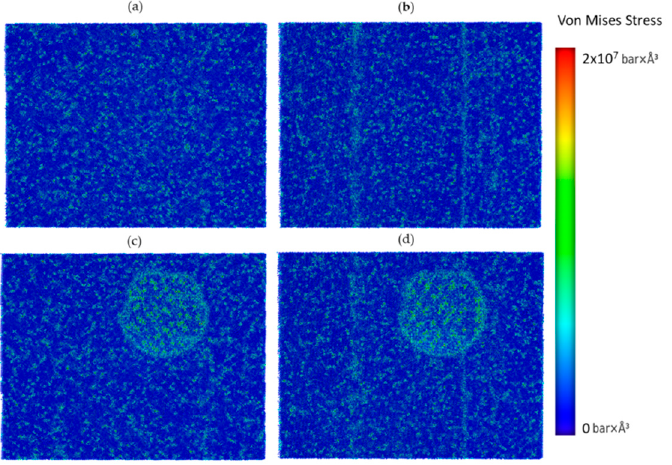
Figure 8. Mises stress distributions after compression in low- ( a,c ) and high-misorientation ( b,d ) grains of the unalloyed ( a,b ) and alloyed ( c,d ) system.